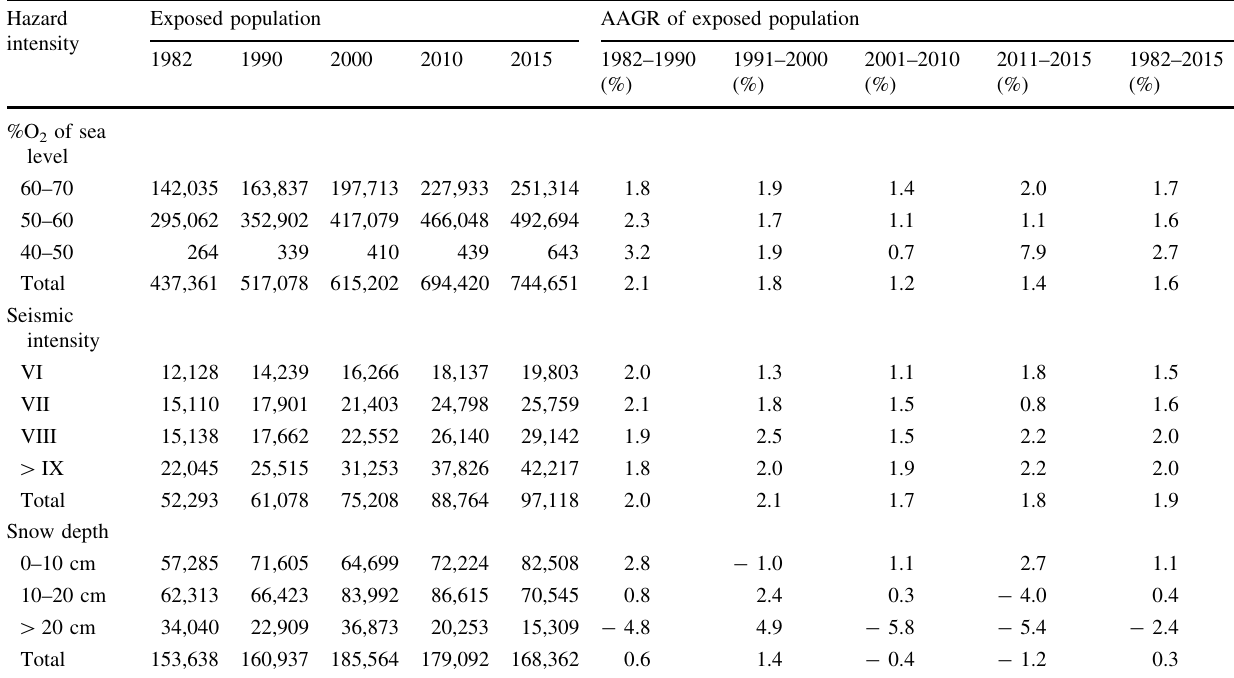
Table 4 Population exposure to each hazard type and average annual growth rate (AAGR) in Tibet,